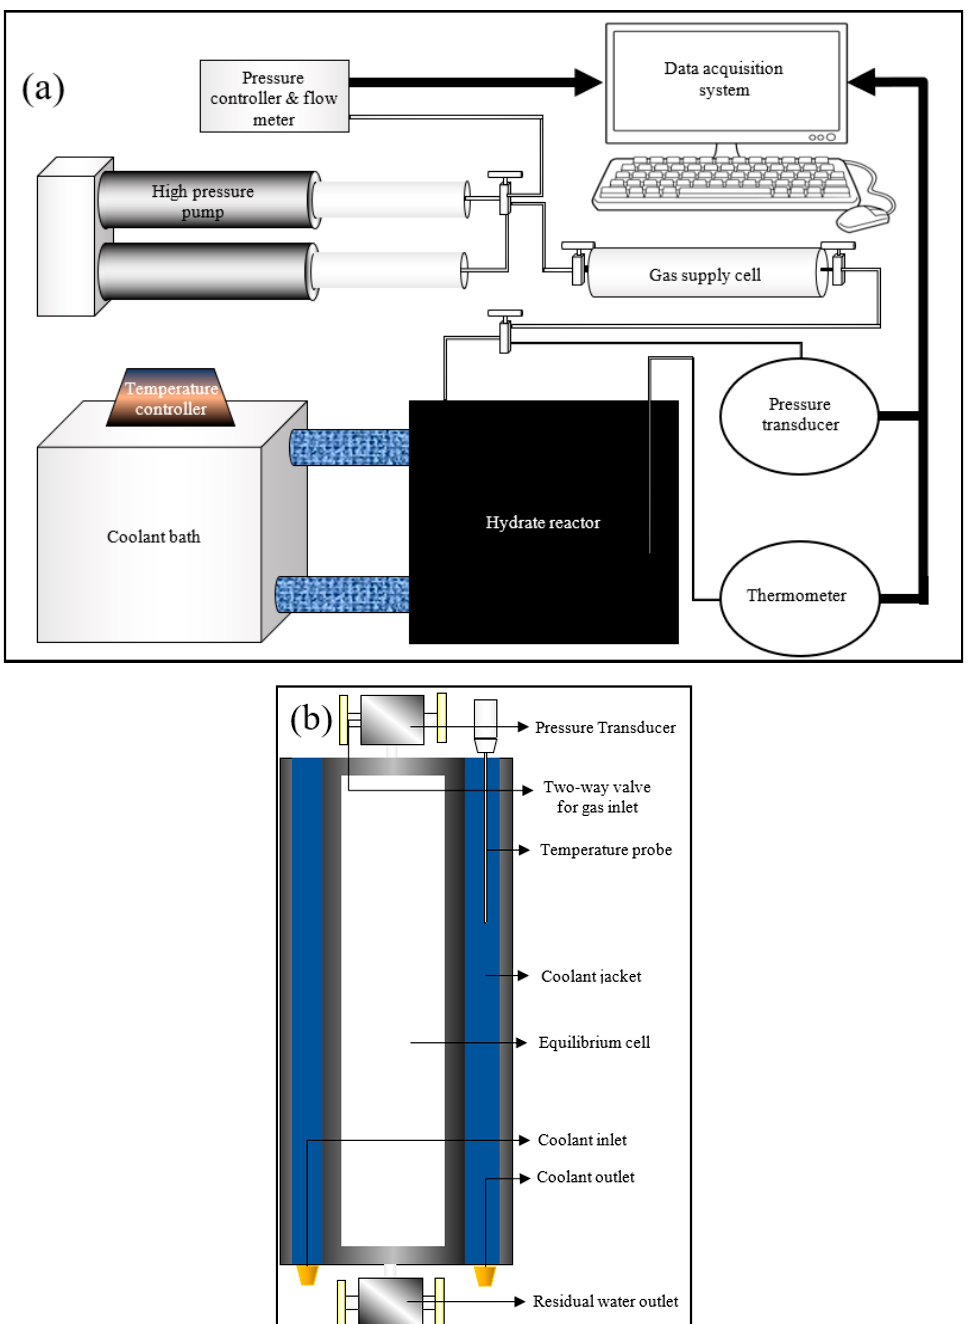
Figure 2. Experimental setup configuration ( a ) and the reactor configuration ( b ).